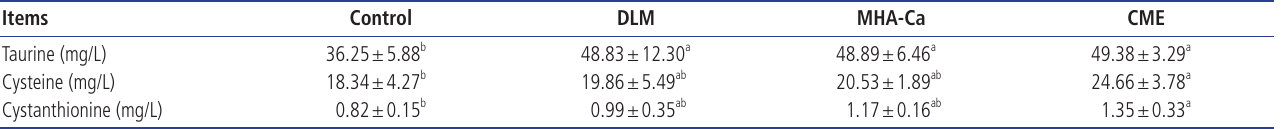
Table 6. Effects of different methionine sources on serum methionine metabolites of broiler